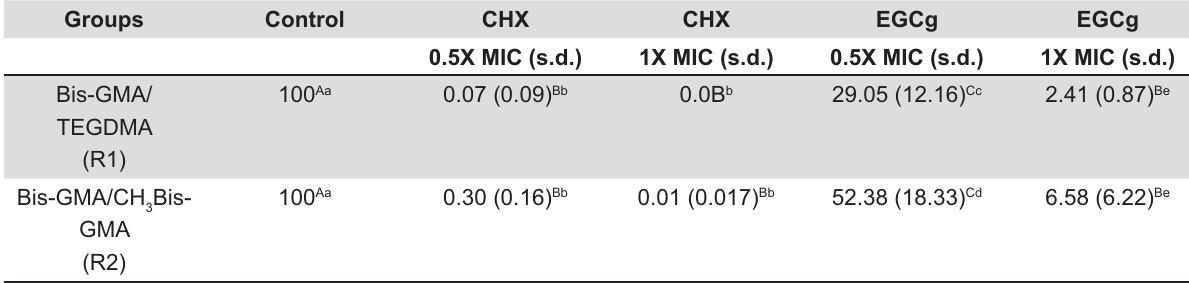
*ANOVA and Tukey’s test; α (cid:2)(cid:3)(cid:4)(cid:3)(cid:5)(cid:6)(cid:7)(cid:8)(cid:4)(cid:9)(cid:4)(cid:10)(cid:7)(cid:8)(cid:11)(cid:12)(cid:13)(cid:9)(cid:12)(cid:14)(cid:9)(cid:7)(cid:9)(cid:15)(cid:16)(cid:17)(cid:12)(cid:11)(cid:17)(cid:18)(cid:13)(cid:6)(cid:7)(cid:19)(cid:12)(cid:20)(cid:15)(cid:7)(cid:21)(cid:22)(cid:22)(cid:15)(cid:14)(cid:7)(cid:23)(cid:12)(cid:8)(cid:15)(cid:7)(cid:24)(cid:15)(cid:11)(cid:11)(cid:15)(cid:14)(cid:8)(cid:7)(cid:17)(cid:13)(cid:9)(cid:17)(cid:23)(cid:12)(cid:11)(cid:15)(cid:7)(cid:13)(cid:18)(cid:7)(cid:8)(cid:11)(cid:12)(cid:11)(cid:17)(cid:8)(cid:11)(cid:17)(cid:23)(cid:12)(cid:24)(cid:7)(cid:9)(cid:17)(cid:25)(cid:25)(cid:15)(cid:14)(cid:15)(cid:13)(cid:23)(cid:15)(cid:7)(cid:26)(cid:17)(cid:11)(cid:27)(cid:17)(cid:13)(cid:7) each line. Same lower case letters indicate no statistical difference within each